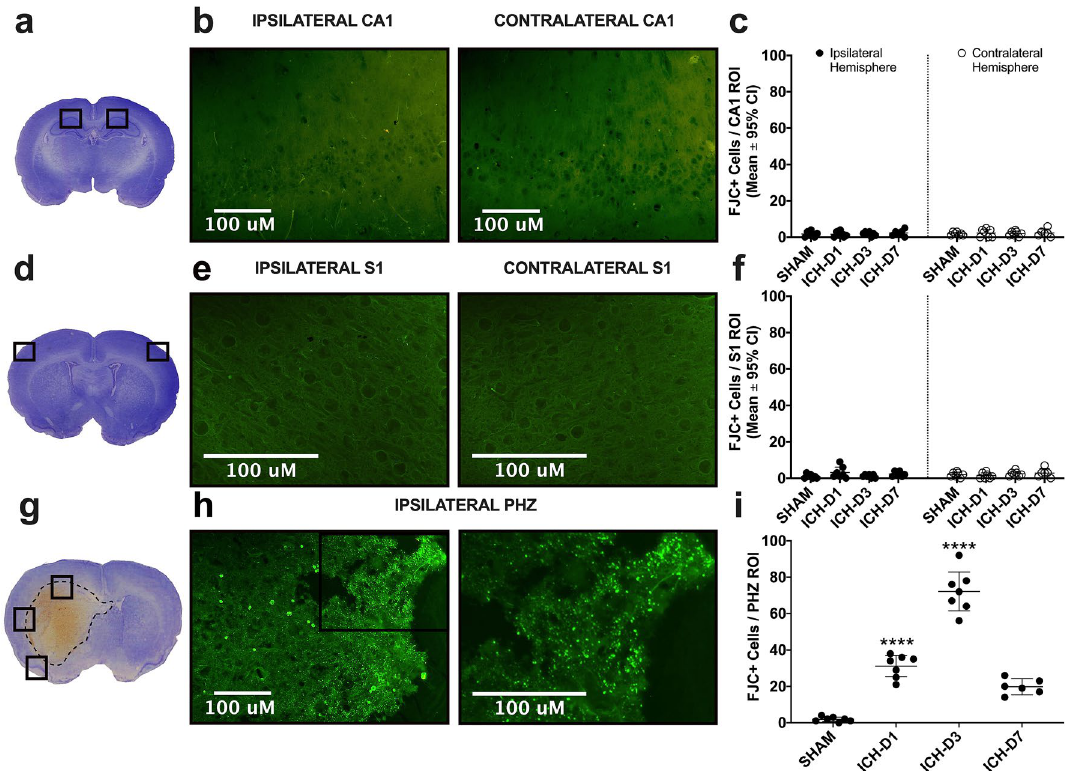
Figure 3. Representative sections and images demonstrating locations of regional sampling for the Fluoro- jade C positive cell counts as a marker of neuronal death in CA1, ( a – c ; 1.78 ± 2.89 on D1, 1.93 ± 1.15 for D3, 2.33 ± 1.97 for D7, versus 1.79 ± 1.18 for SHAMs), S1 ( d – f ; 3.14 ± 2.9 on D1, 1.14 ± 0.83 on D3, 2.33 ± 1.43 on D7, versus 1.5 ± 1.68 for SHAMs), and the perihematoma zone (PHZ; g – i ) after ICH. A representative example of the hematoma size is delineated by the dotted black line ( g ). Representative images in CA1 were taken at 20 × objective magnification ( b ), while those in S1 were taken at 40 × ( e ). PHZ representative images ( h ) were taken at 20 × and 40 × objective magnification respectively to better demonstrate the extent of cells positive for FJC + stain, with the approximate area in which the higher magnification image was taken marked by a box on the lower magnification image. **** p < 0.0001 versus SHAM controls. Figure and scatterplots were made using GraphPad Prism version 8.4.3 for macOS, GraphPad Software, San Diego, California USA, www.graph